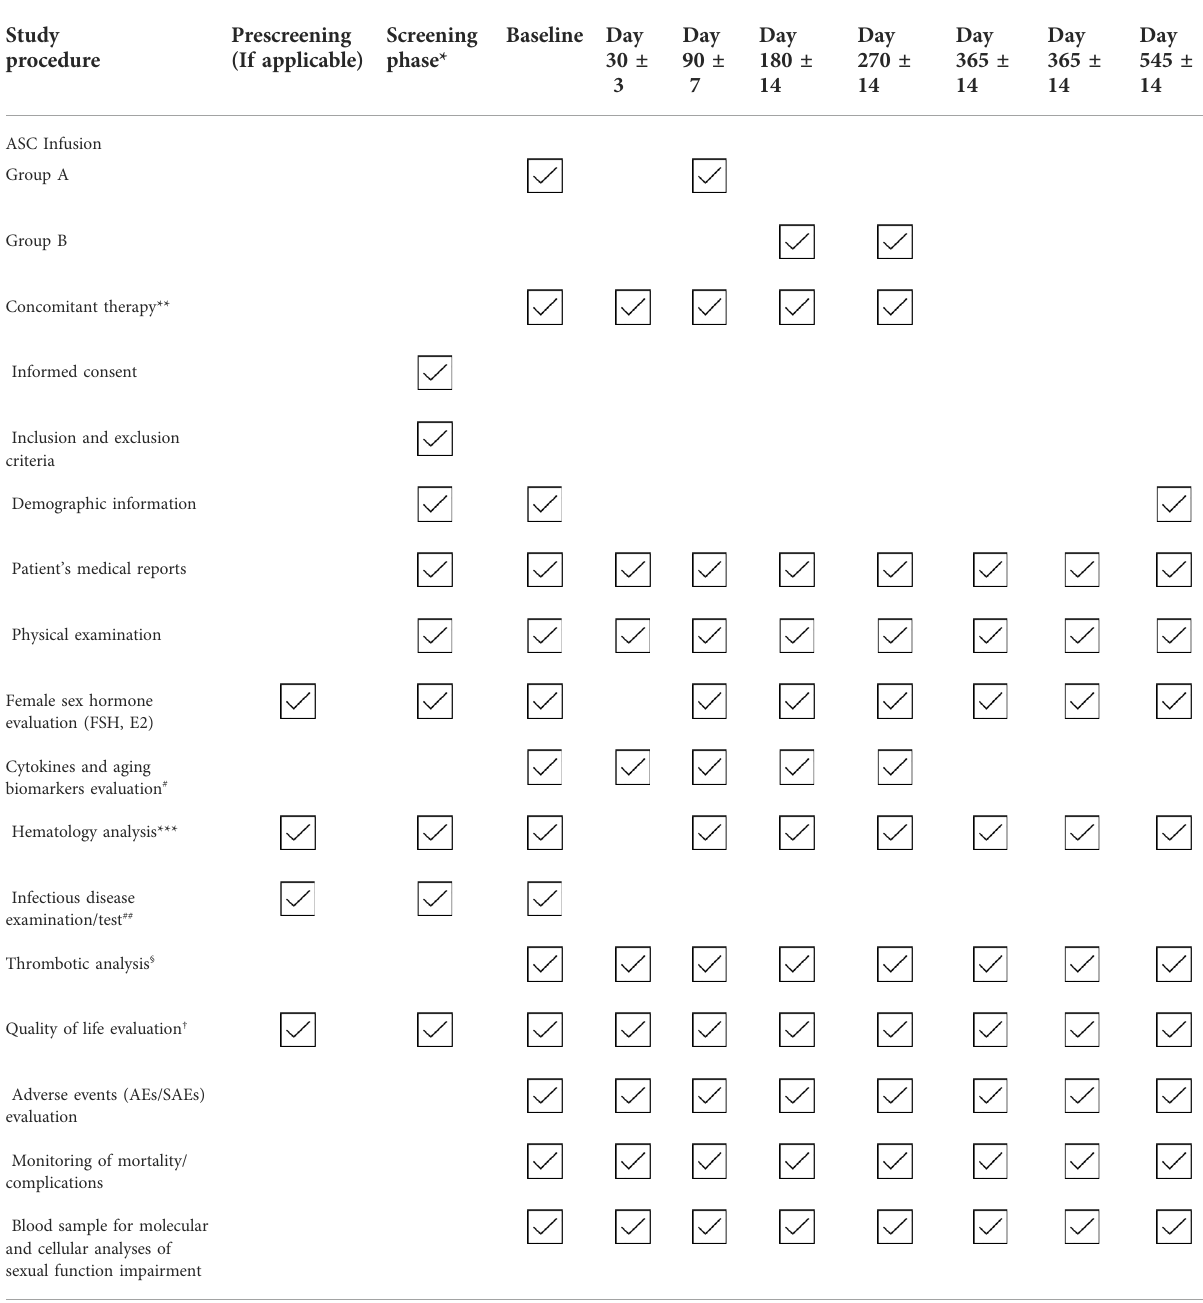
TABLE 1 Study timeline and clinical procedures during the